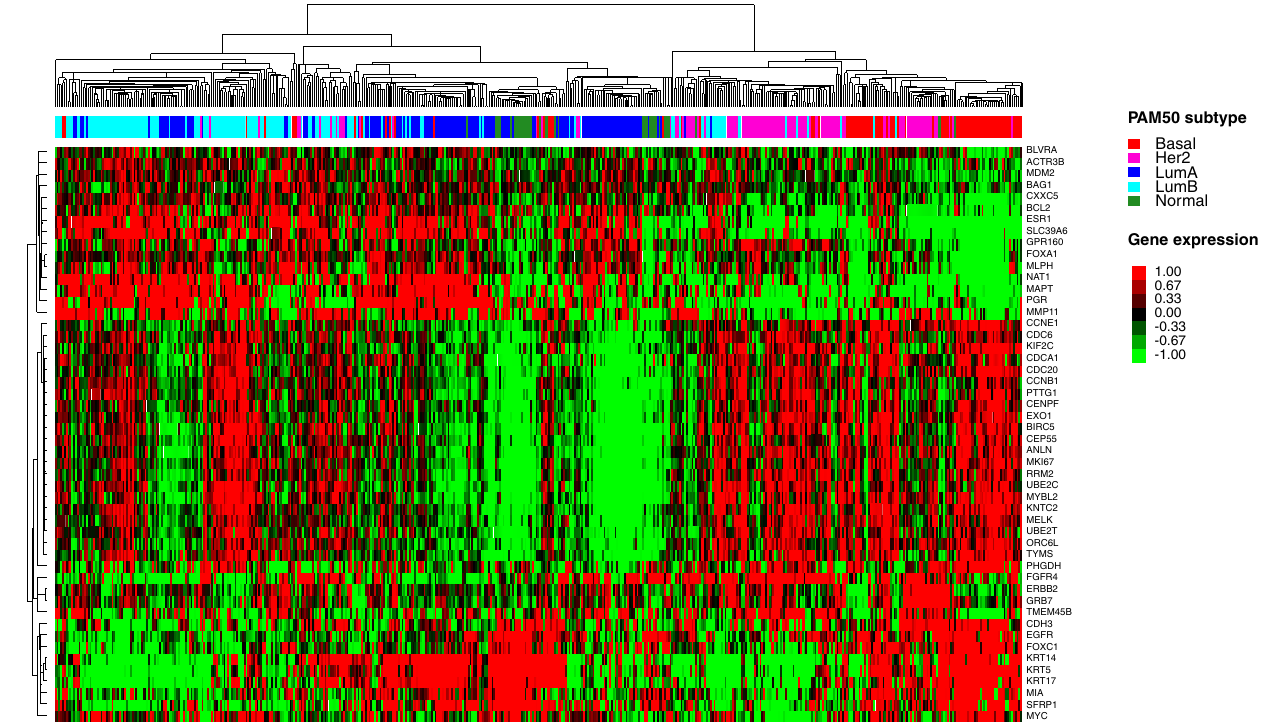
Fig. 1 Heatplot representing the original, non-commercial PAM50 intrinsic subtypes ’ genes, and gene expression patterns. Median centered unsupervised hierarchical clustering representing the breast cancer intrinsic subtypes (Luminal A, Luminal B, HER2-Enriched, Basal- like) and the Normal-like group, identi fi ed using the research-based PAM50 assay on the nCounter ® platform, in a set of 527 archived breast cancer fresh-frozen paraf fi n-embedded (FFPE) samples from Dr. Prat ’ s laboratory. Each column represents a single patient ’ s sample. The red color represents relatively high gene expression, green represents relatively low gene expression, and black represents median gene expression. The PAM50 gene list is reported on the right side of the heatplot. The unsupervised cluster and heatmap were obtained with R version 3.6.1, Cluster 3.0, and Javatreeview 1.1.6r4 for MacOSX. LumA luminal A, LumB luminal B, Her2 HER2-Enriched, Basal Basal-like, Normal genes, which exhibit a continuum of expression levels 26 . Hence different cut-offs distinguishing between a high and low proliferation level may impact on a single sample classi fi cation when different IS predictors are used. Conversely, the distinct features of the Basal-like subtype (i.e., high expression of basal cytokeratins, lack of expression of estrogen- and HER2-related genes) 27 are likely responsible for the high levels of agreement in Basal-like identi fi cation among different IS classi fi ers.